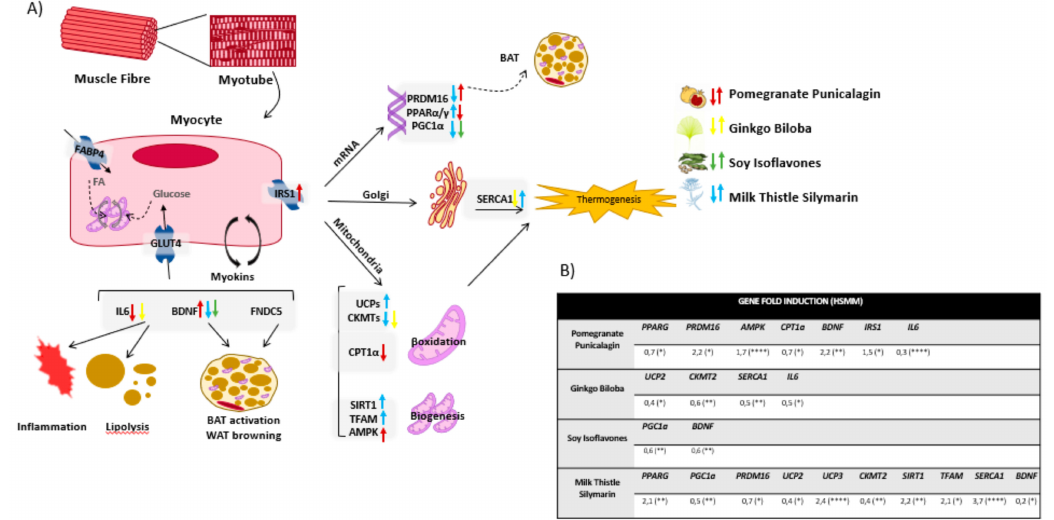
Figure 5. ( A ) Graphical representation of genes modulated by the extracts in differentiated human myocytes HSMM compared to no-treated cells. Up or down arrows indicate upregulation or downregulation in gene expression after treatment with the extracts. Statistically significant genes whose expression was modulated in differentiated myocytes HSMM after 48h of treatment with the extracts, compared to non-treated cells. ( B ) Mean fold induction of at least 3 independent experiments are shown. Asterisks indicate significant statistic differences * < 0.01, ** < 0.005, **** <